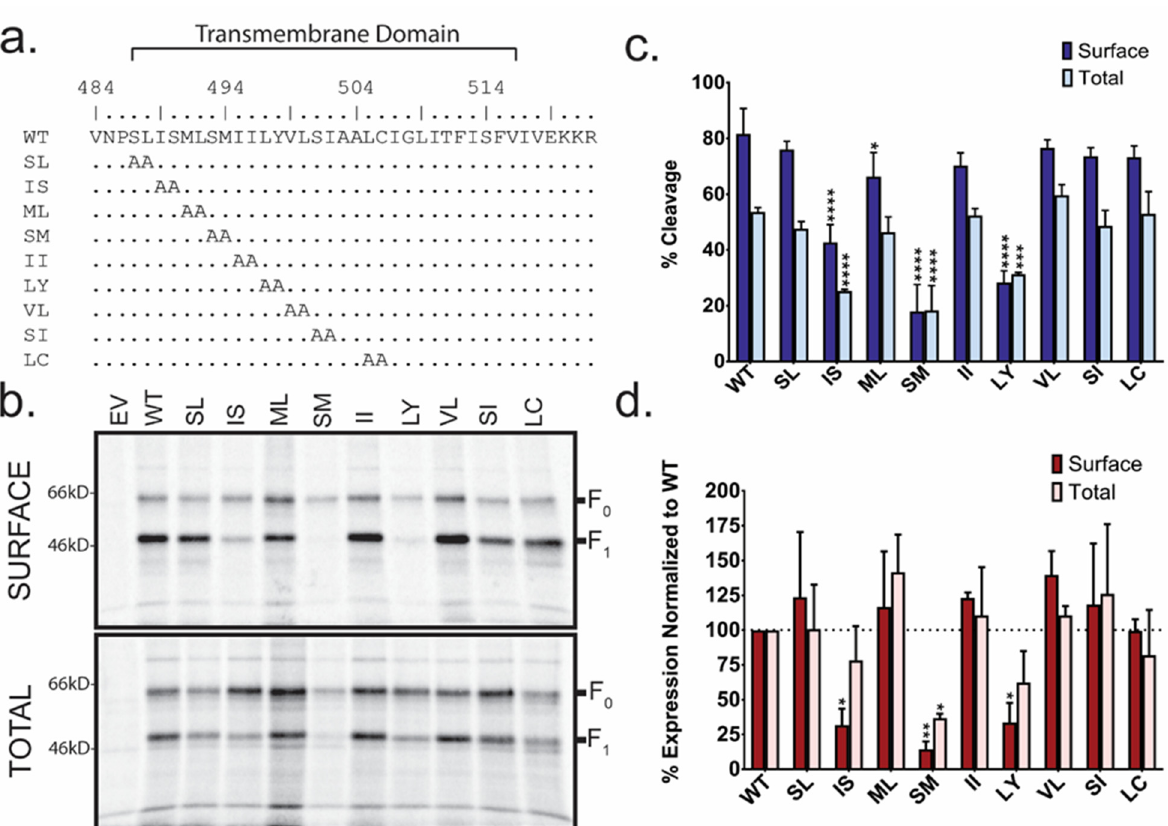
Figure 1. Several Hendra virus (HeV) F transmembrane (TM) mutants have impaired protein expression and protein cleavage. ( a ) Alanine scanning mutations at the N-terminus of the HeV F TM were generated to assess the importance of these residues. The putative boundaries of the TM are indicated. ( b ) Surface biotinylation was performed to analyze the surface and total population of HeV F for empty vector (EV), WT and each of the mutants created. Cells were radiolabeled for 3 h. Using band densitometry, percent expression ( c ) and percent cleavage ( d ) was measured for the total and surface protein. All measurements represent the average of three independent experiments ± SD, and all samples were normalized to WT. Significance was determined by two-way analysis of variance (ANOVA) * = p < 0.05, ** = p < 0.01, *** = p < 0.005, **** = p < 0.001.